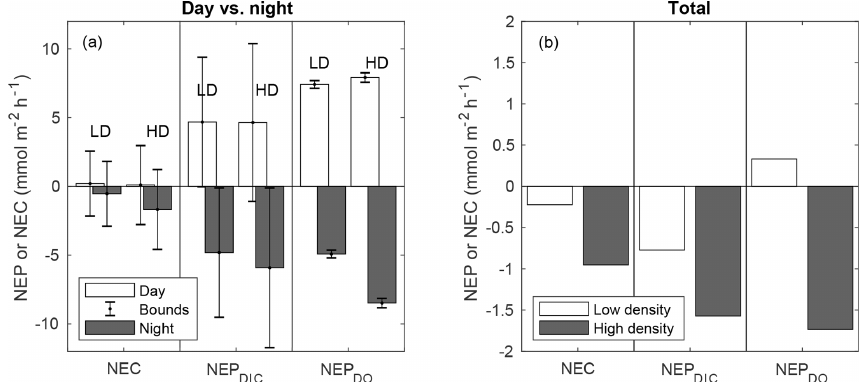
Figure 6. NEC, NEP DIC , and NEP DO integrated over daytime and nighttime periods (a) and over the entire study period (b) . NEP values are shown for k 600 of Ho et al. (2006). The error bars in panel (a) represent upper and lower bounds for metabolic rates determined in Sect. 2.8.